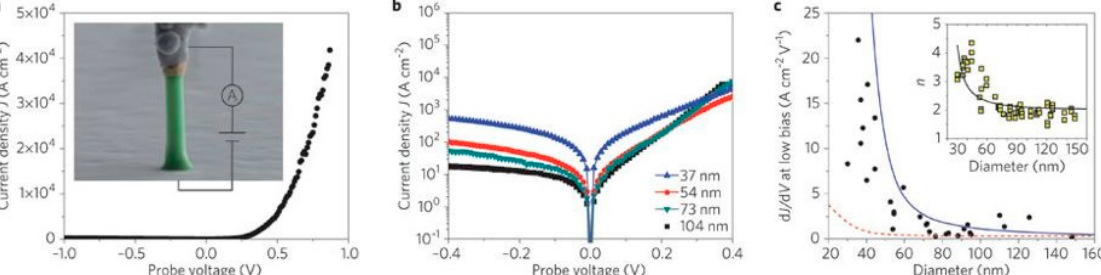
Figure 1. ( a ) End-on Au/Ge nanowire Schottky diode. ( b ) Current-voltage measurements for contacts to nanowires of different diameter. ( c ) Calculated conductance dI/dV based on a diameter-dependent (solid line) versus diameter-independent (dashed line) recombination time. Inset shows corresponding ideality factor versus wire diameter. Reprinted with permission from American Physical Society, Ridge, NY, USA [20].